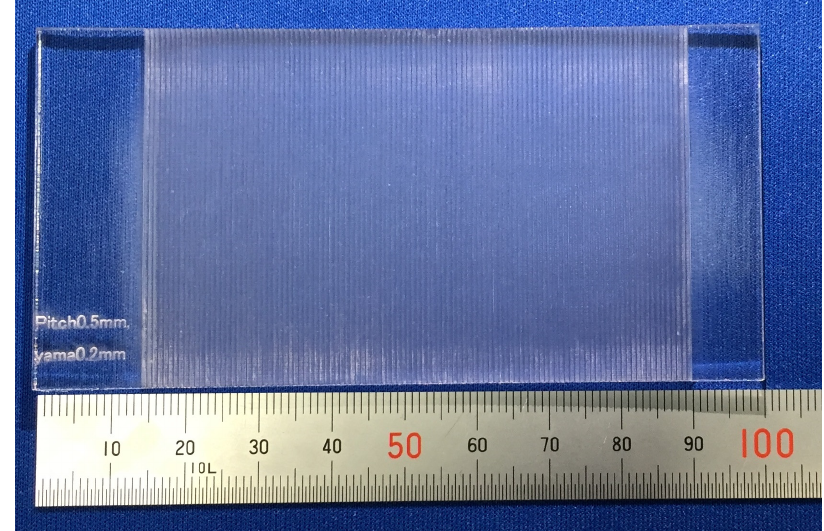
Figure 9. Textured surface used for the experiment. Pitch width: 0.6 mm.